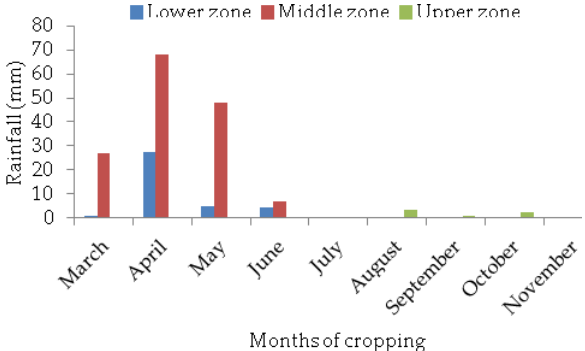
Figure 2. Mean monthly rainfall recorded on a daily basis (and averaged) during the periods of plant growth in three agro-ecological zones. The small mean monthly rains recorded in the upper zone (September to November) were expected since the sowing of crops in this zone is usually done during short rains due to excessive rains during long seasons experienced in from March to June. Crops in the upper zone benefit from residual moisture and spells of